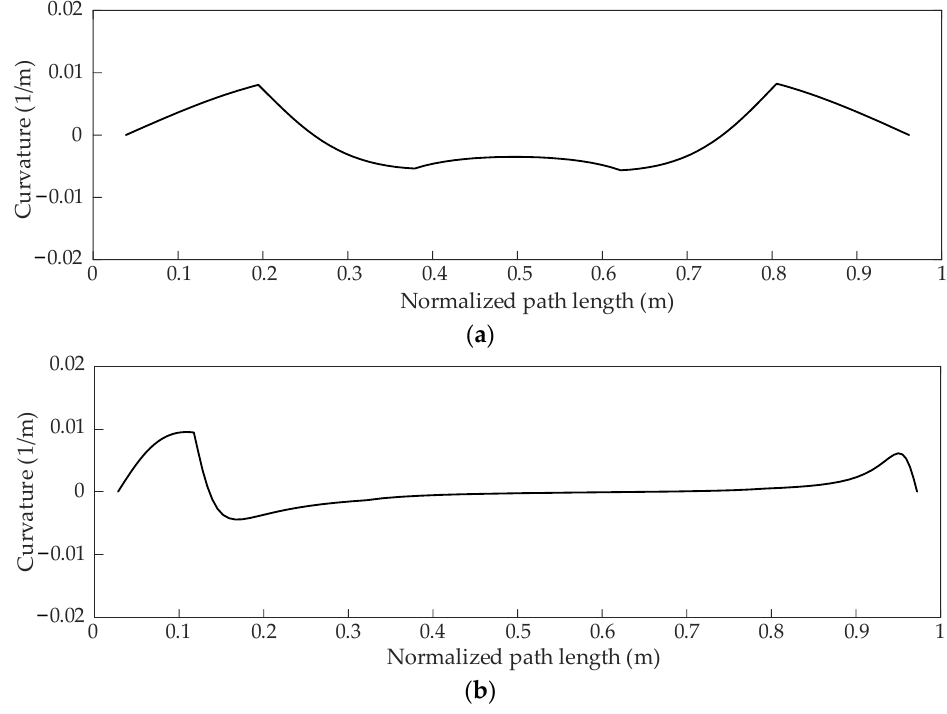
Figure 15. The simulation path curvatures. ( a ) The path curvature in straight road scenario. ( b ) The path curvature in curved road scenario.